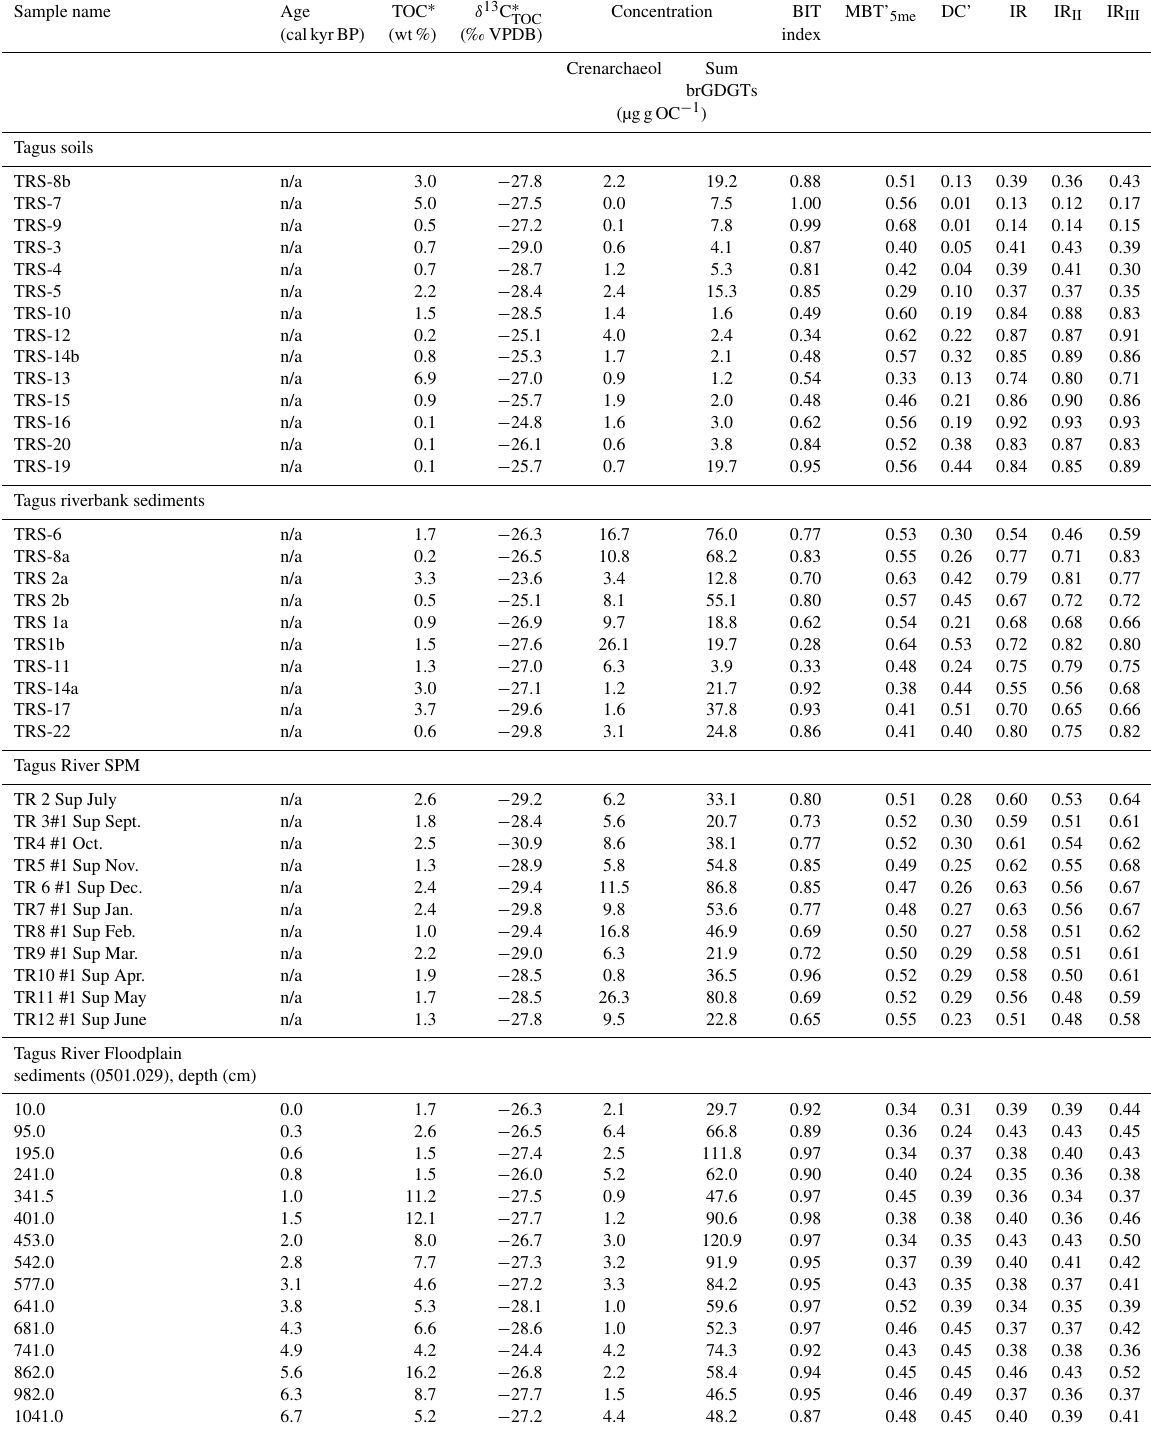
Table 3. Concentrations of GDGTs and brGDGT-based indices for each sample set along the